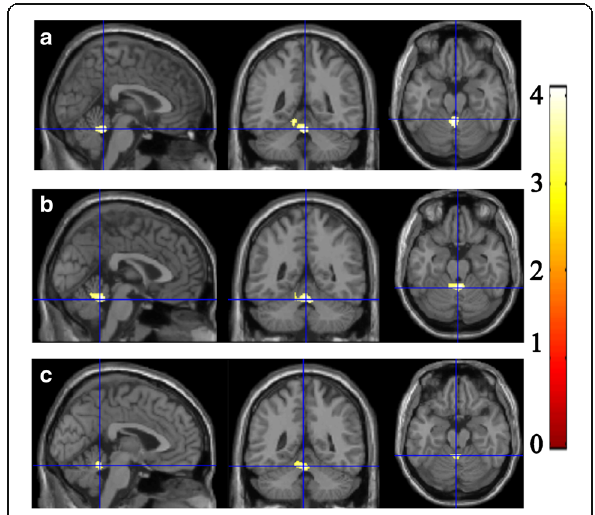
Fig. 5 Alteration of Texture Energy, Entropy and IDM. Line ( a ), The brain regions with decreased Energy located in vermis and left cerebellum exterior in MOH; ( b ), Line b and c , The brain region with increased Entropy and decreased IDM both located in vermis in MOH